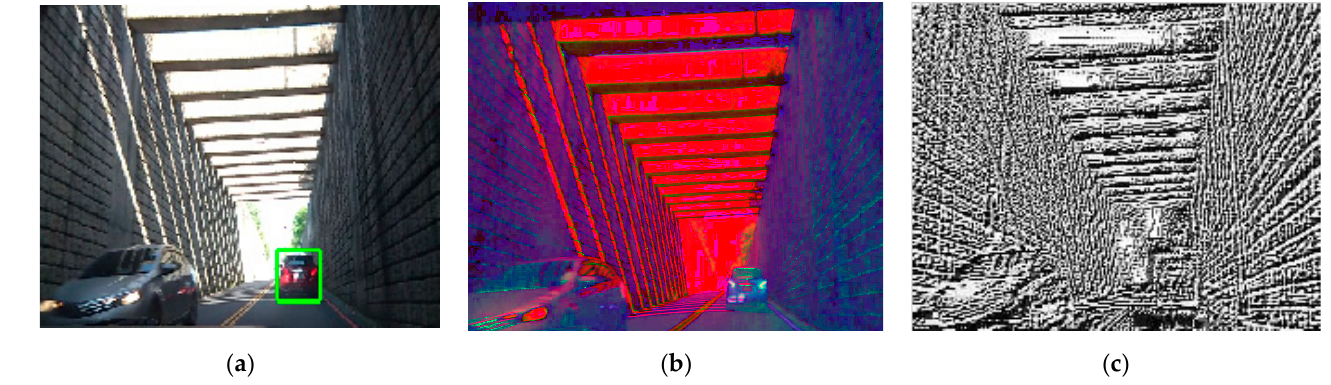
Figure 2. There are two sub-functions in the operation of ADMTCF: ( a ) one sub-function is calcu- lating the response that is used to obtain the response of the four templates after adaptively resiz- ing forward up, down, left, and right directions; ( b ) another sub-function is called the adaptive adjustment template which expands or shrinks the size of the template.